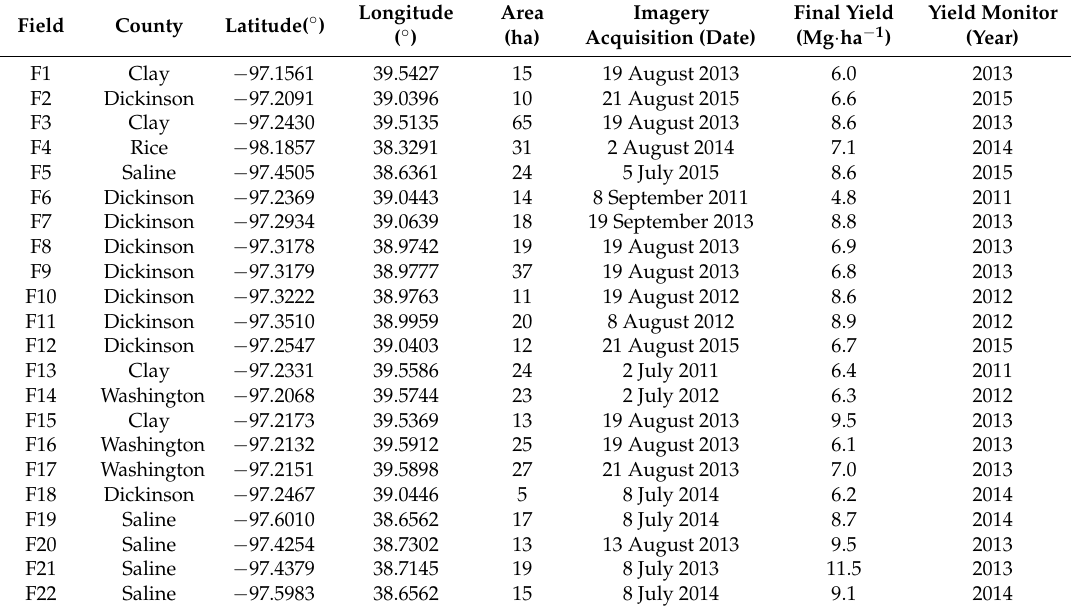
Table 1. Descriptive information for each farm field collected during 2011–2015 related to county, latitude and longitude, total area (in hectares, ha), date for imagery acquisition (RapidEye platform), monitor